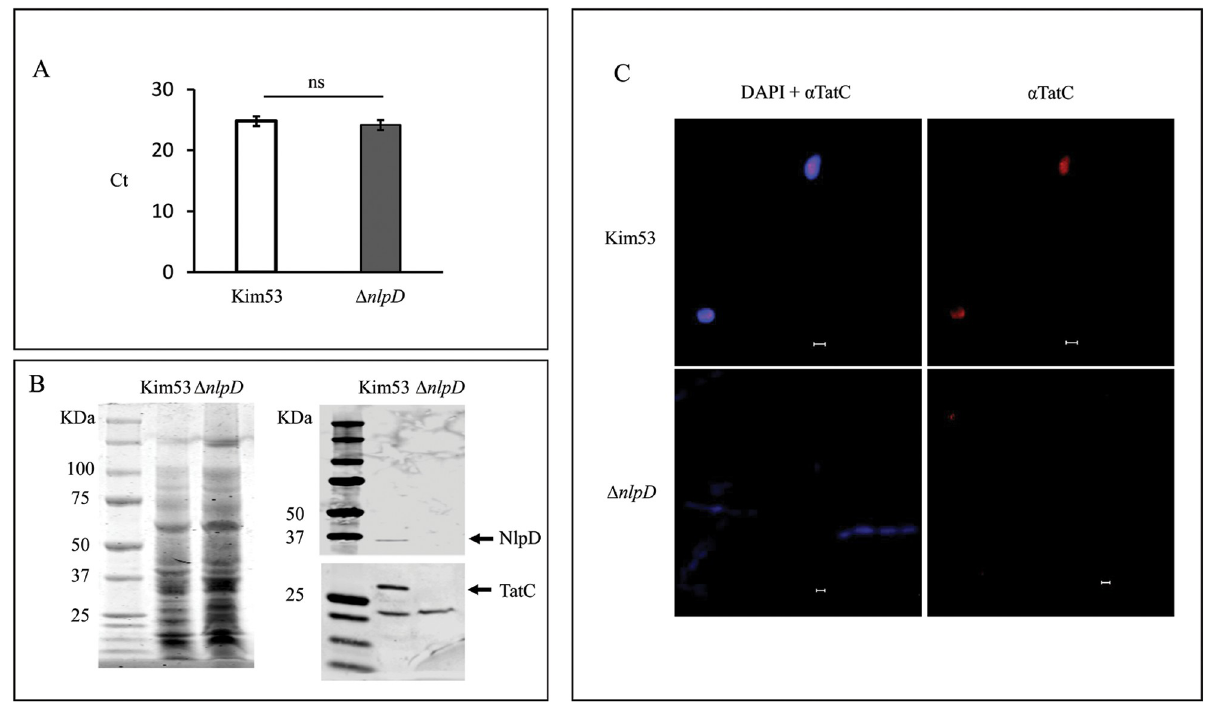
Fig 3. Expression of TatC in the Y . pestis strains. A. Quantitative RT-PCR analysis of tatC mRNA levels. mRNA from Kim53 (white histogram) and the nlpD mutant (gray histogram) was subjected to qRT-PCR analysis of tatC gene expression. The relative mRNA level was determined by calculating the threshold cycle ( Δ Ct) of target genes via the classic Δ Ct method [90]. The results presented are an average of three independent experiments. B. Western blot analysis of TatC protein levels in total cell lysates of the wild-type Kim53 strain and the nlpD mutant. Whole cell lysates (10 6 cfu/lane grown at 37˚C), were subjected to Western blot analysis using anti-NlpD and anti-TatC antibodies. The Coomassie blue stained gel and the blots were derived from the same experiment and were processed in parallel. C. Distribution of TatC protein on the bacterial membrane of Y . pestis strains. Fluorescence microscopy images of wild-type Kim53 (top panel) and the nlpD mutant (lower panel) are presented after TatC staining alone (right panel) or with DAPI staining (left panel). Images (100 × ) were captured with a Zeiss LSM 710 confocal microscope (Zeiss, Oberkochen, Germany). Scale bar = 1 μ m. The inset shows a magnification ( × 3) of stained bacterial cells. The data presented are representative of at least two independent experiments and the displayed data is one representative